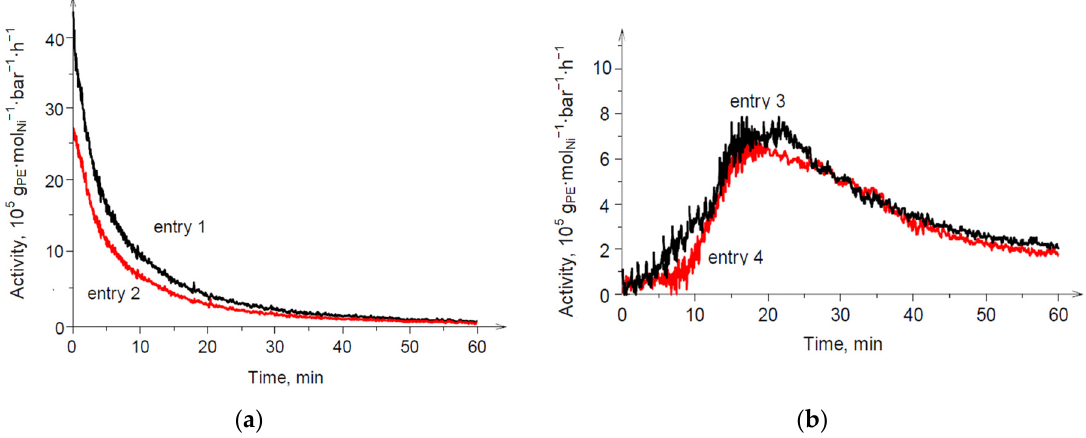
Figure 5. Ethylene consumption rate time profiles for the catalyst systems L 2 Ni II Br 2 /MMAO (entry 1), L 2 Ni II Br 2 /AlMe 3 (entry 2) ( a ), and L 2 Ni II Br 2 +MMAO (20 equiv)/MMAO (entry 3), L 2 Ni II Br 2 +AlMe 3 (10 equiv)/AlMe 3 (entry 4) ( b ).